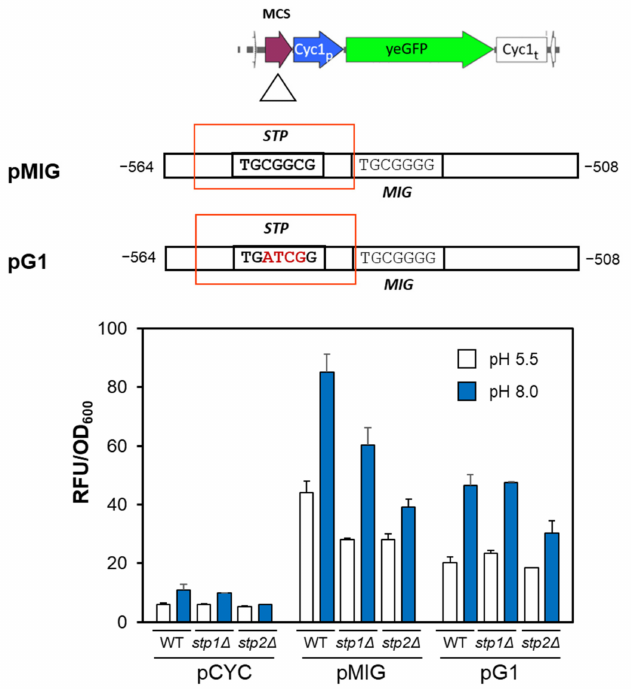
Figure 2. Mutation of the putative Stp1/2 site decreases expression from the pMIG reporter. Upper panel. The structure of the MIG region was cloned into the pCYC vector. The nucleotides mutated in pG1 are denoted in red. The lower panel shows the expression at normal or alkaline pH from the empty vector (pCYC), pMIG, or pG1 in BY4741 wild-type cells (WT) or its stp1 ∆ and stp2 ∆ derivatives. In this case, induction was carried out for 6 h, cells were fixed for flow cytometry, and fluorescence was recorded with the fluorimeter. Data are mean ± SEM from three independent